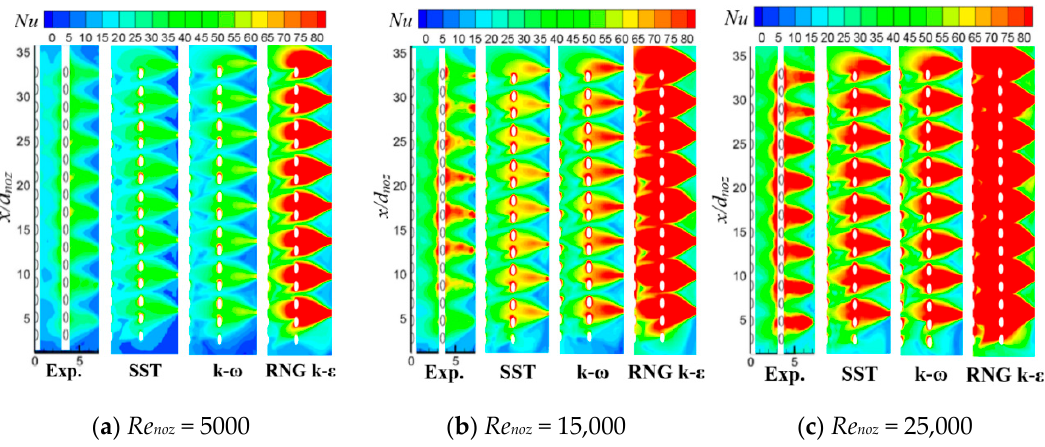
Figure 3. Nusselt number contours for both experimental (without mainstream [39]) and numerical results of swirl cooling at ( a ) Re noz = 5000, ( b ) Re noz = 15,000 and ( c ) Re noz = 25,000.